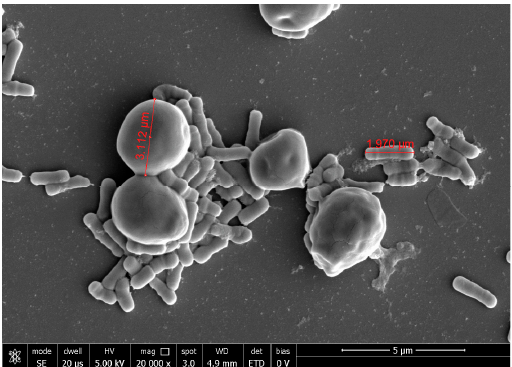
Figure 3. Representative image of L. rhamnosus LRH020 and C. albicans observed at SEM. Magnification 20,000×.